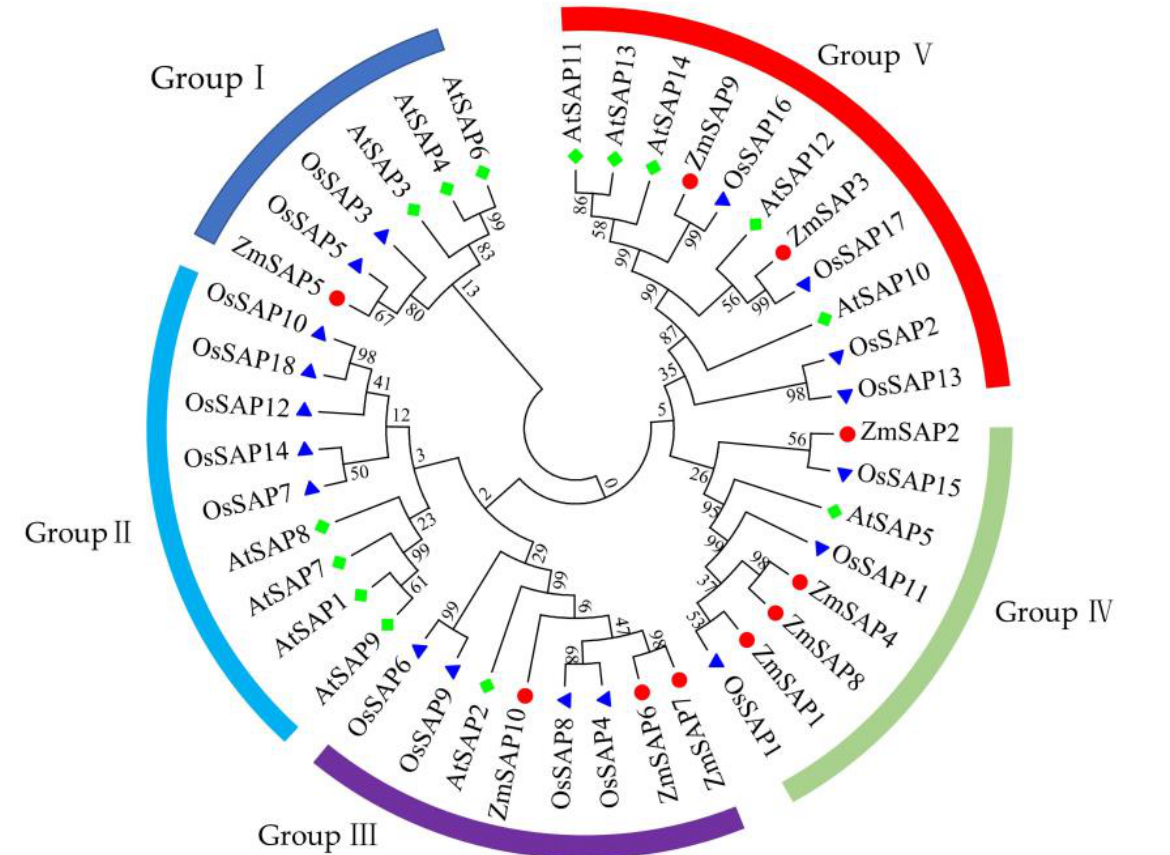
Figure 2. Phylogenetic evolutionary tree of SAP family in maize, Arabidopsis and rice. The red dot indicates the ZmSAP, the blue triangle indicates the OsSAPs, and the green diamond represents the AtSAPs.